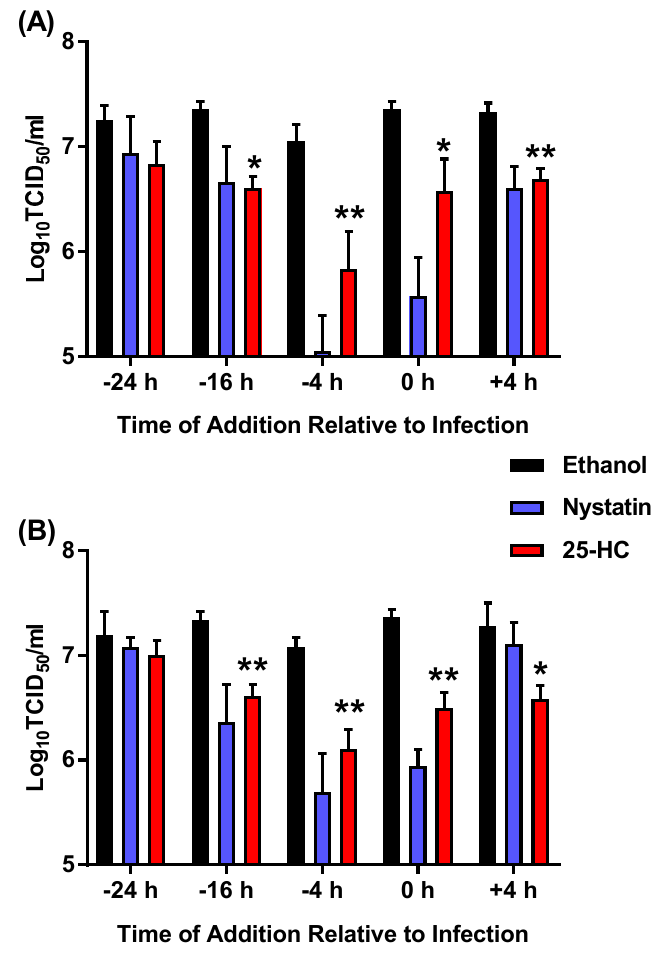
Figure 3. Pre-treating RAW264.7 cells with 25-HC inhibits MNV replication. RAW264.7 cells were pre-treated with 25-HC (6.6 µ M), nystatin (50 µ M) or the ethanol-only control at 24, 16 or 4 h before infection ( − 24 h, − 16 h or − 4 h, respectively), and the compounds were removed prior to the addition of MNV at ( A ) 0.05 TCID 50 /cell or ( B ) 5 TCID 50 /cell. Subsequently, the cells were infected with MNV and immediately treated with the compounds (0 h) or treated at 4 h post-infection (+4 h) after removal of the virus. At 48 h post-infection, the supernatants were removed, clarified by centrifugation and production of infectious virus determined by TCID 50 assay on RAW264.7 cells. Data show mean virus titer and statistical analysis of 25-HC by comparison to the ethanol-only control ( n = 3 ± SEM, * = p < 0.05, ** = p < 0.01).